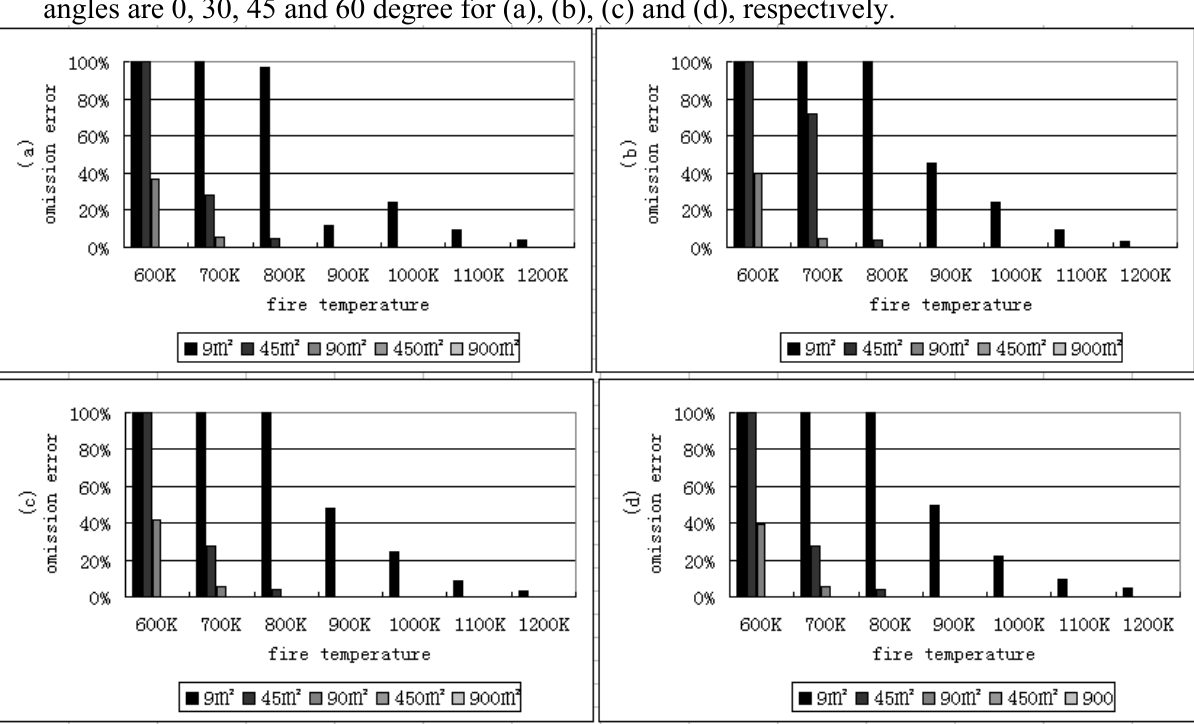
Figure 7. Omission errors of fire detection for different fire areas (m 2 ) and temperatures (K)